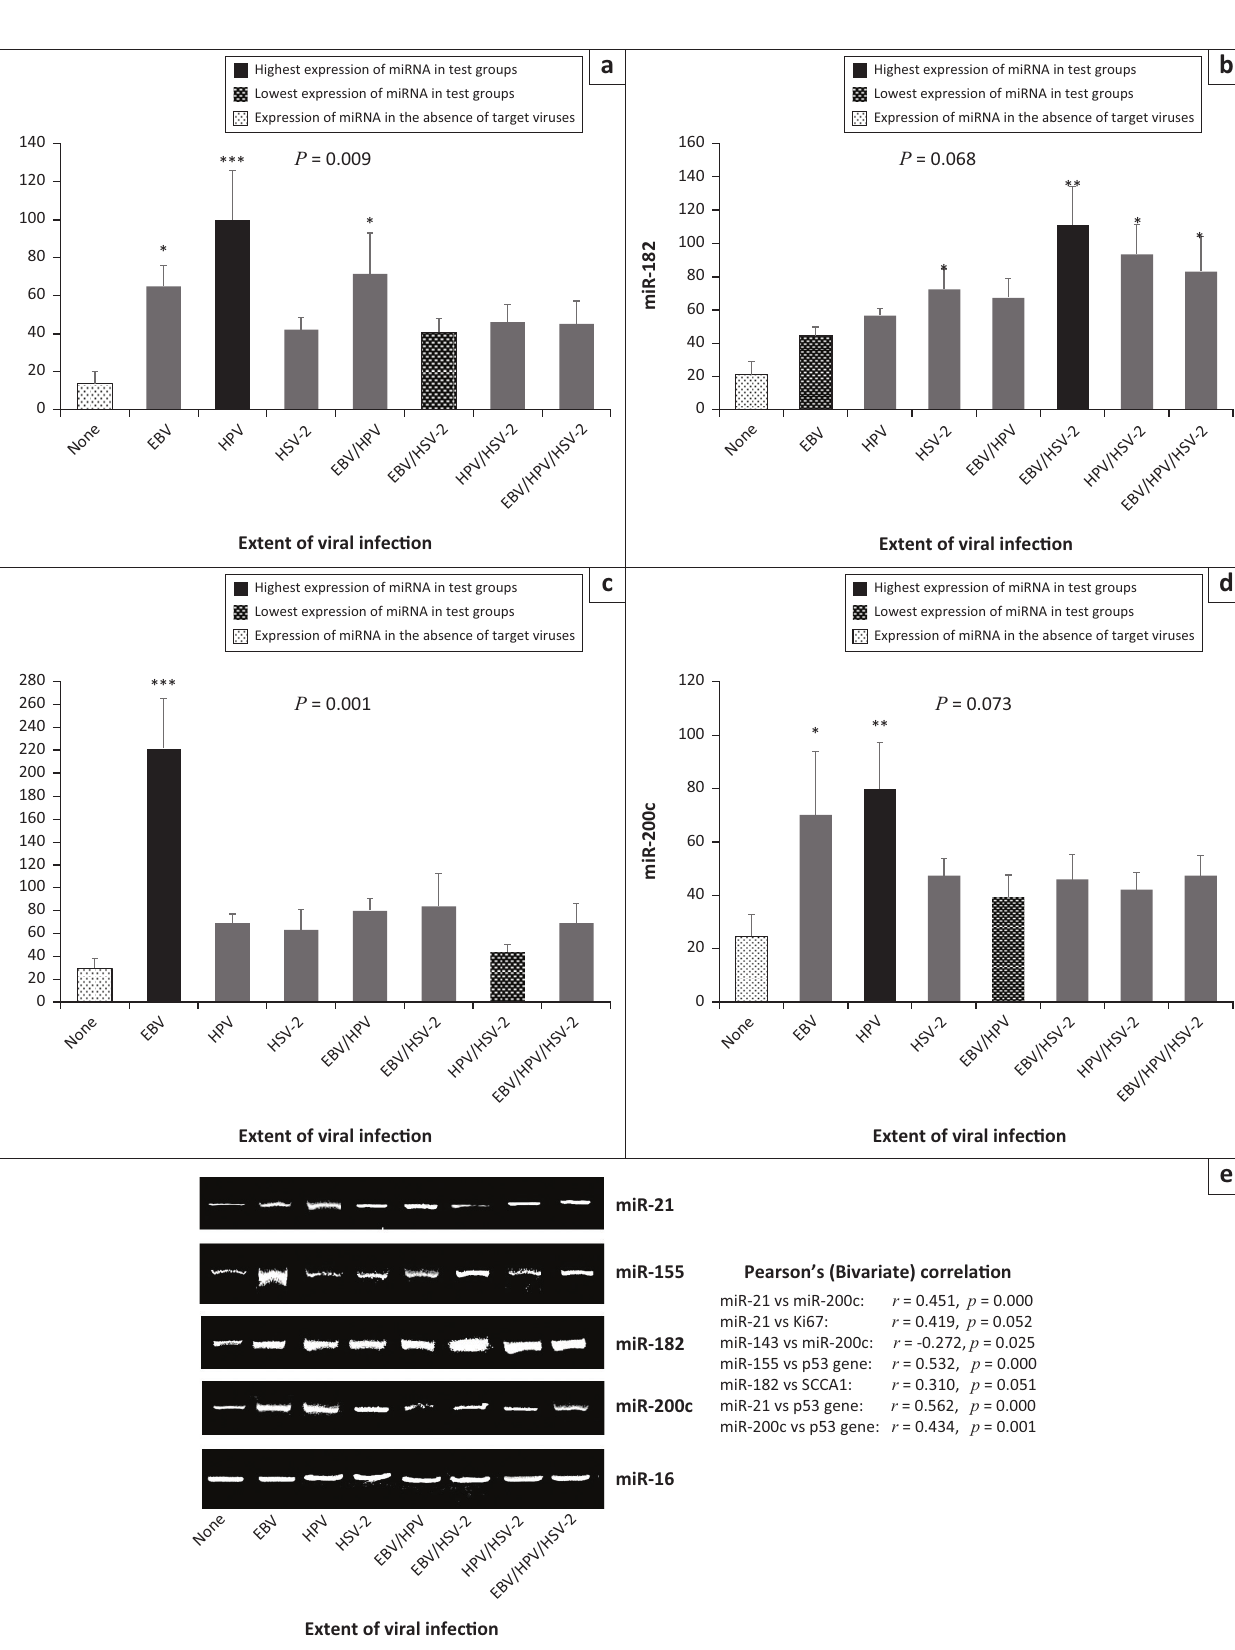
FIGURE 1: Relative expression of oncogenic miRNAs among individuals with and without viral infection, Ogun State, Nigeria, 2018. (a) miR-21 expression was higher among participants with HPV mono-infection; (b) miR-182 expression was higher among participants with EBV and HSV-2 bi-infection; (c) miR-155 expression was higher among participants with EBV mono-infection; (d) miR-200c expression was higher among participants with HPV mono-infection; (e) Snapshots of gel amplicons of oncomirs and normalising gene (miR-16) based on viral status (plotted as